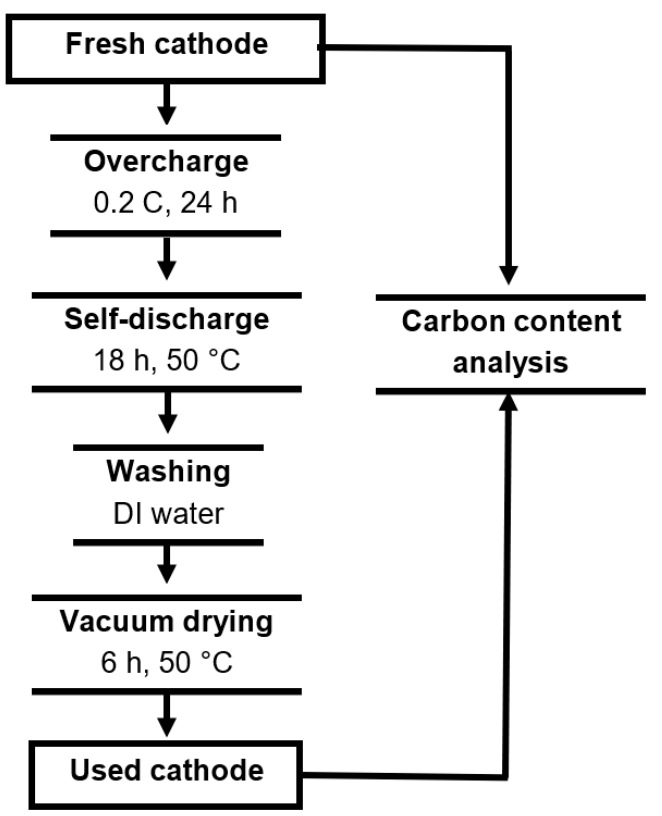
Scheme 1. Flow chart of the carbon stability test for a LiMn 2 O 4 cathode.